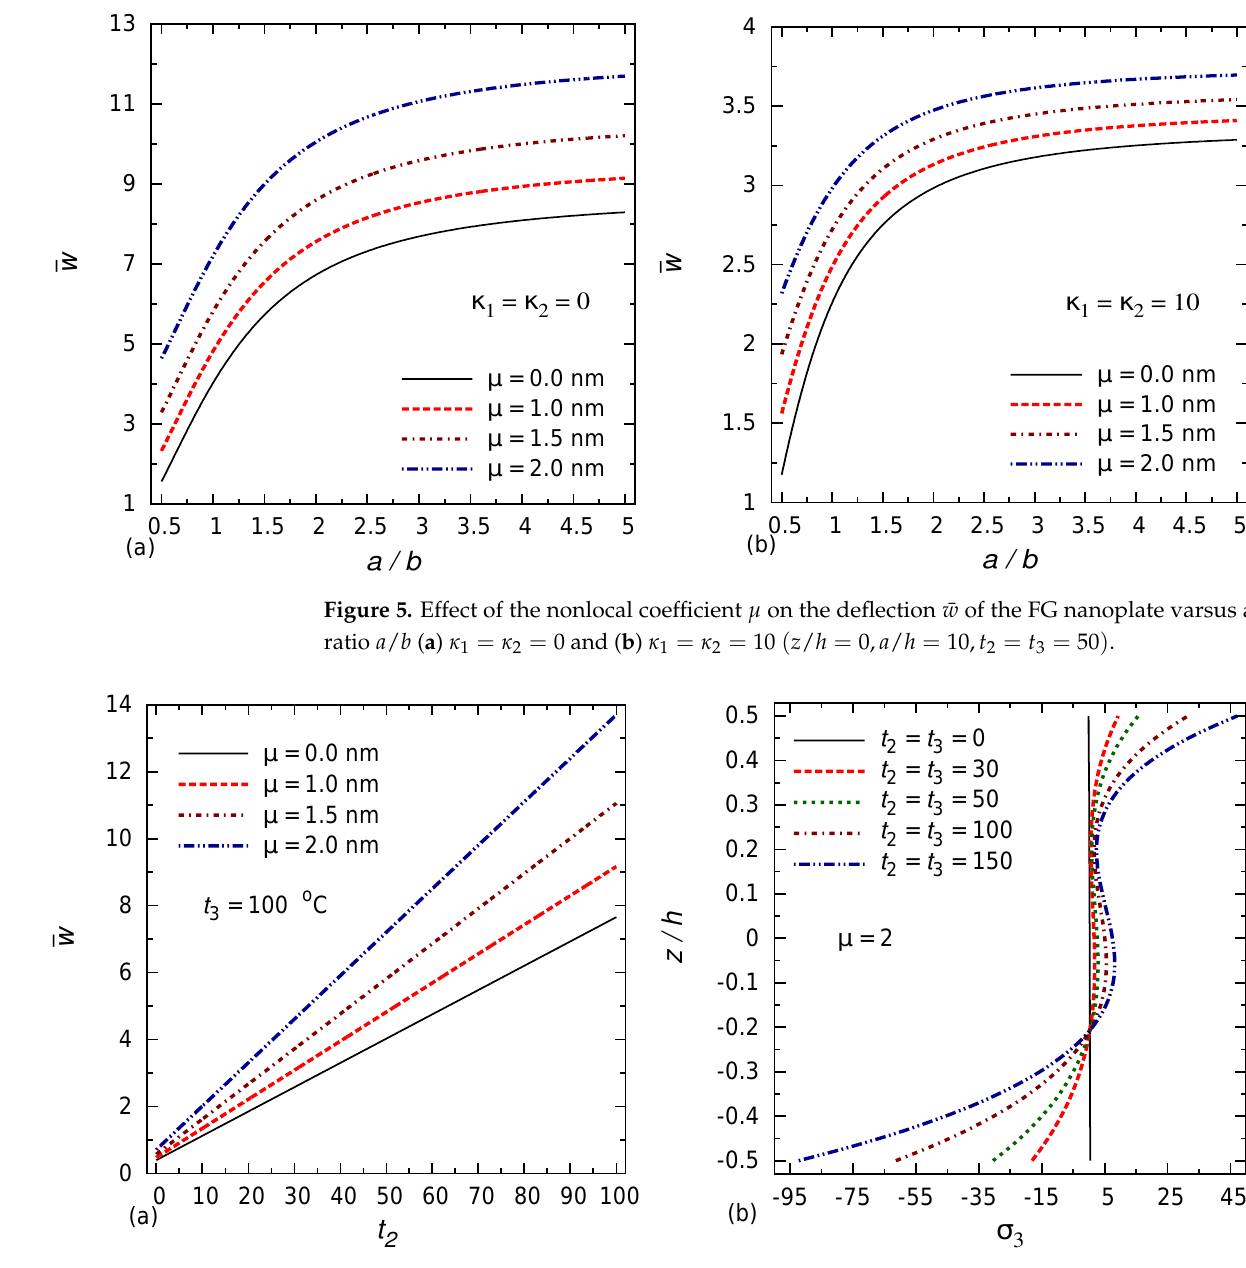
Figure 6. ( a ) Effect of the nonlocal coefficient µ on the deflection ¯ w ( z / h = 0 ) and ( b ) effect of the thermal loads t 2 and t 3 on the transverse normal stress σ 3 through the thickness in FG square nanoplates ( κ 1 = κ 2 = 0, a / h = 10 )